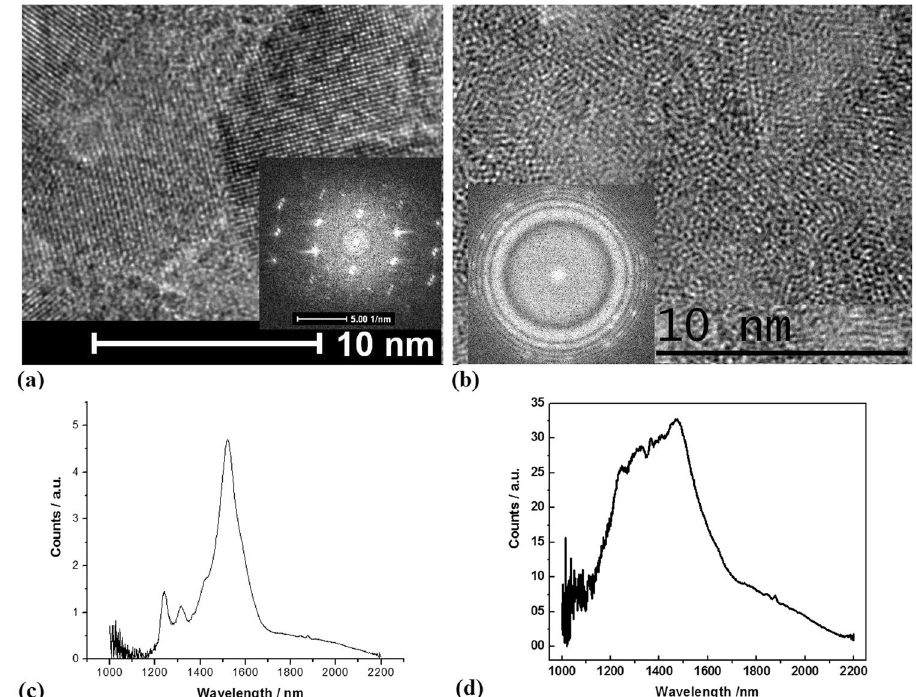
Figure 6. ( a ) The TEM image of the crystal structures of the pillars sample I prepared in vacuum and their FFT pattern shown in the inset, which exhibits the various defects; ( b ) The TEM image of the crystal structures of the pillars sample II prepared in oxygen of 80 Pa and their FFT pattern shown in the inset, which exhibits the defects doped with oxygen; ( c ) The PL spectrum on the sample I indicating the defects states from D1 to D4; ( d ) The PL spectrum on the sample II prepared in oxygen showing the broader impurities states near the defects states.